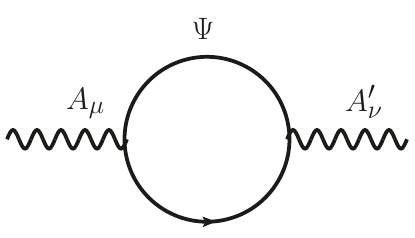
Figure 4. Diagram representing the one-loop charge renormalisation that induces a mixing between the visible sector U(1) gauge (cid:12)eld A (cid:22) and the hidden sector U(1) 0 gauge (cid:12)eld A 0 (cid:12)eld charged under both gauge